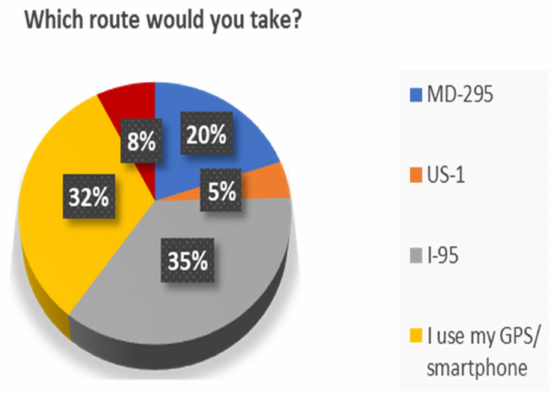
Figure 5. Stated route choice responses.